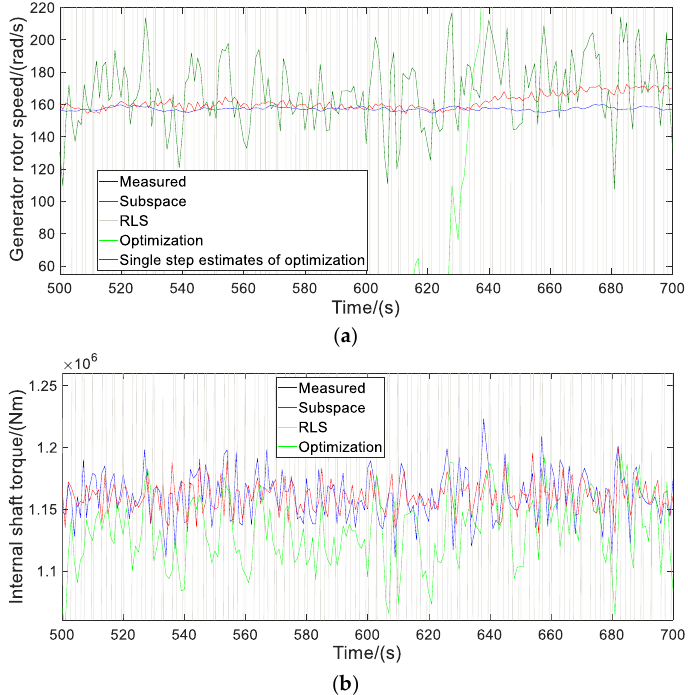
Figure 10. ( a ) Comparison of generator rotor speed under scenario Type 3; ( b ) Comparison of internal shaft torque under scenario Type 3. Energies 2019 , 04 , x FOR PEER REVIEW